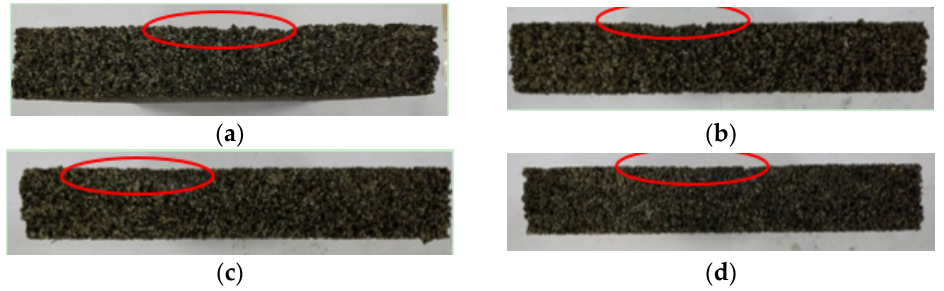
Figure 9. The side views of abrasion specimens under different curing conditions. ( a ) 70 °C & 6 h, Note: 𝛔 = 2.83 MPa, E = 5.07 MPa; ( b ) 100 °C & 6 h, Note: 𝛔 =3.61 MPa, E = 8.08 MPa; ( c ) 90 °C & 6 h. Note: 𝛔 = 3.27 MPa, E = 6.02 MPa; ( d ) 80 °C & 6 h, Note: 𝛔 =3.02 MPa, E = 5.50 MPa